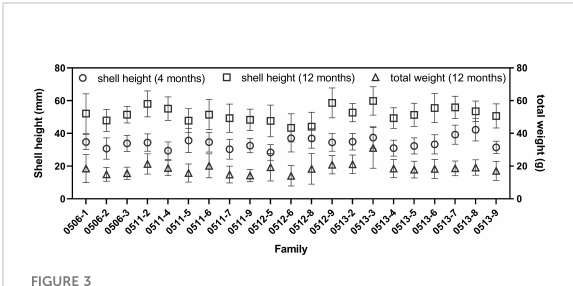
FIGURE 3 Shell height at 4- and 12-month-old and total weight at 12- month-old of different families of Crassostrea angulata